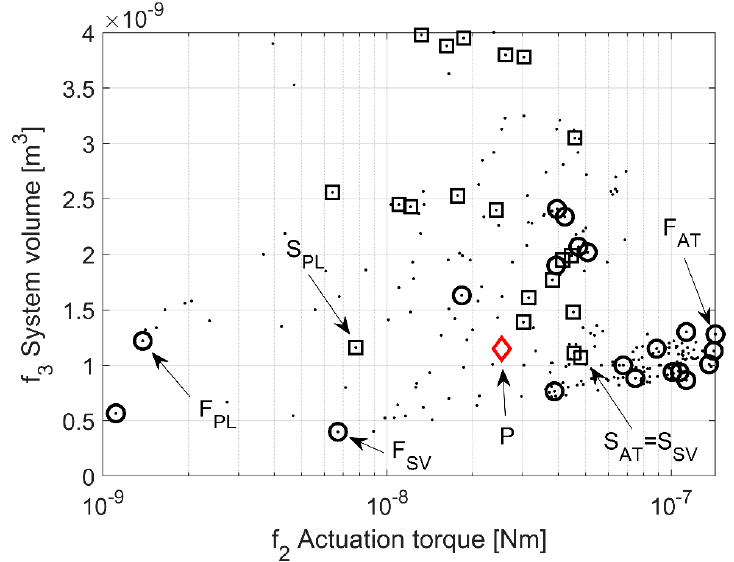
Figure 12. f 2 –f 3 projection of the objective space: dot—individuals, square—starting points, circle—final solutions.